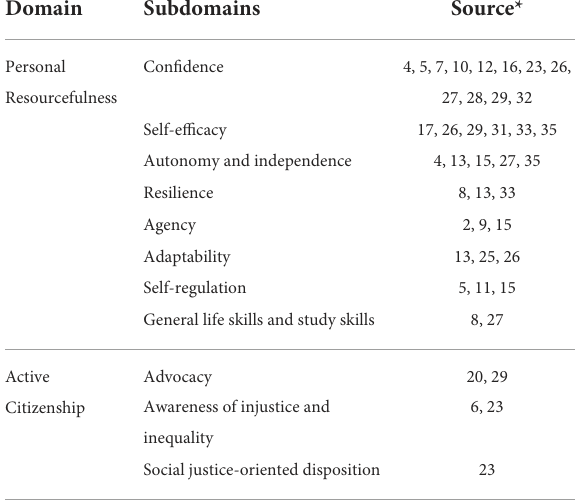
TABLE 4 Doctoral graduate attributes domains and